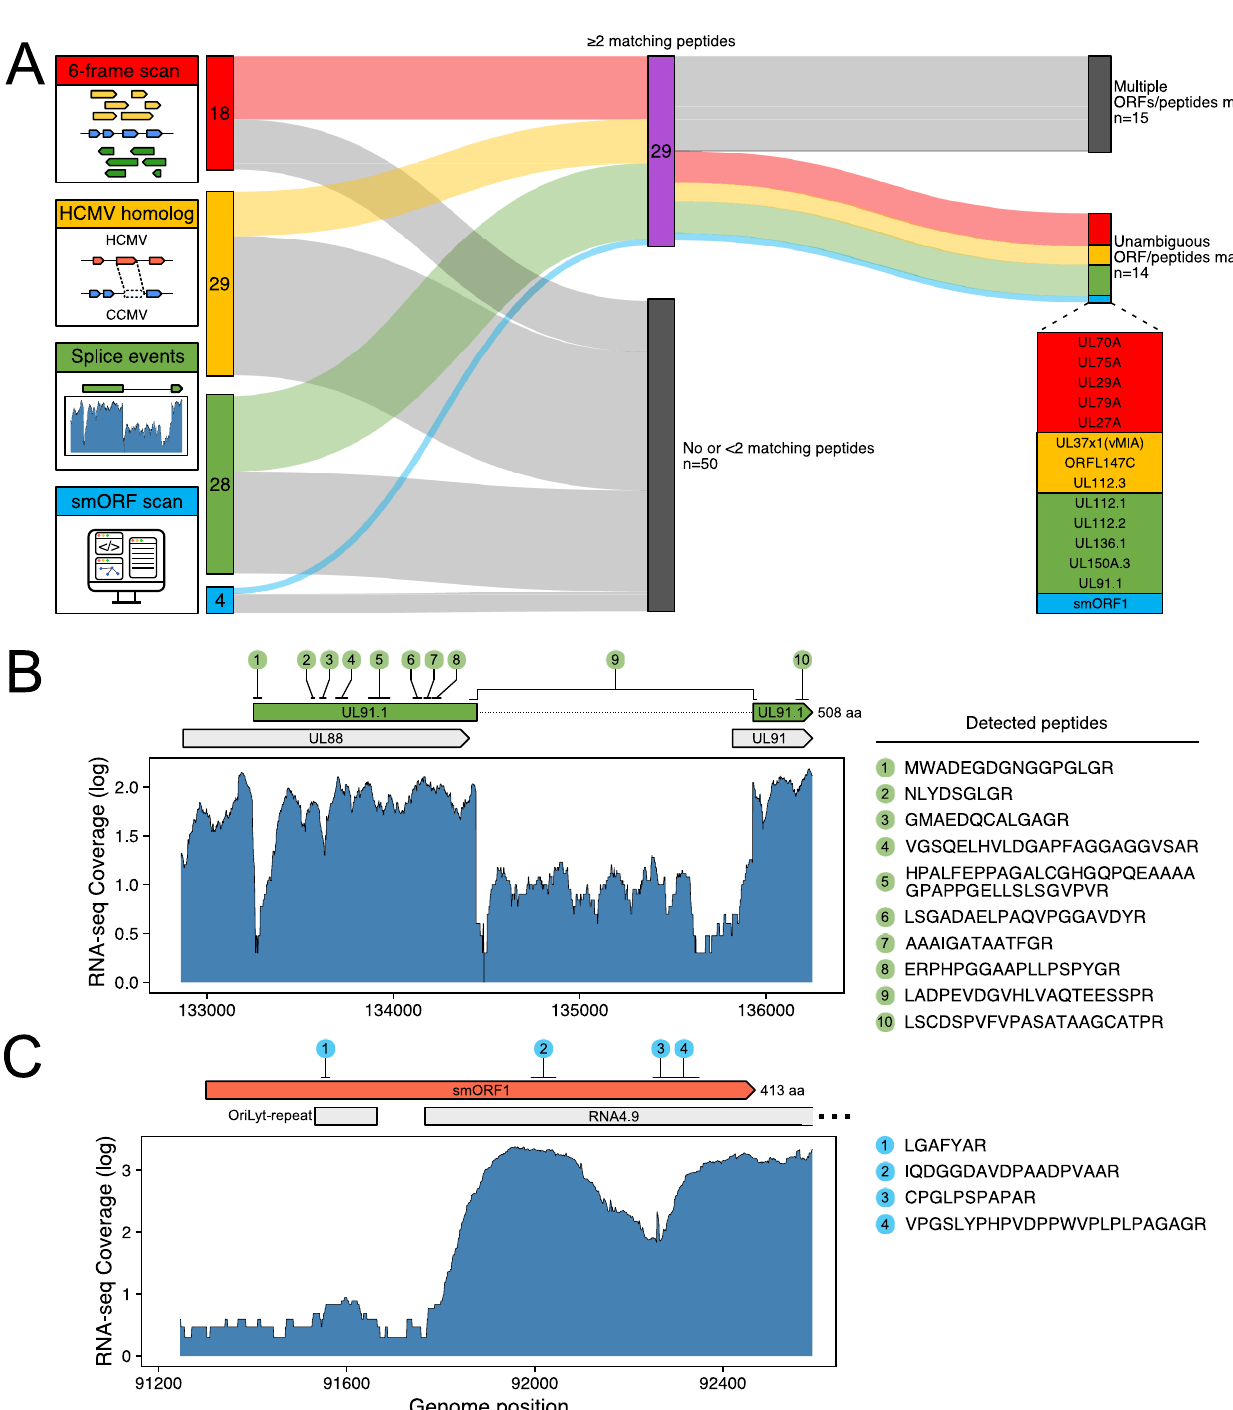
PLOS Pathogens| https://doi.org/10.1371/journal.ppat.1010193 January4,